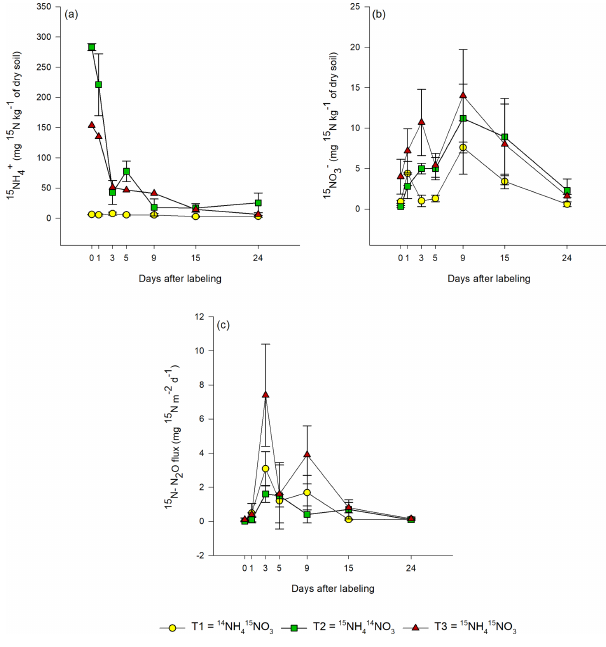
Figure 3. Evolution of the 15 N concentration in (a–b) extractable inorganic-N pools (NH + and NO − ) and (c) N 2 O emissions from 4 3 bare peat (BP) soil during the 24d of the experiment for all label- ing scenarios: T1 – Treatment 1 ( 14 NH 4 15 NO 3 ), T2 – Treatment 2 ( 15 NH 4 14 NO 3 ) and T3 – Treatment 3 ( 15 NH 4 15 NO 3 ). Day 0 de- notes 1h after labeling. Data are mean values ± 1SE ( n =